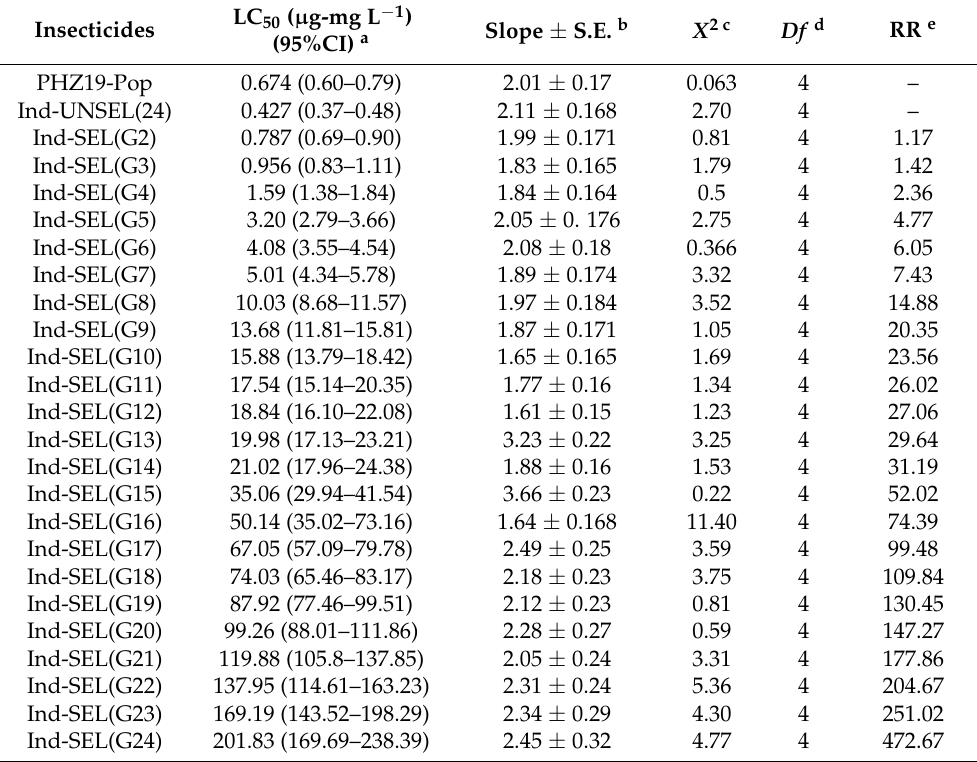
Table 1. LC 50 values with a resistance ratio of laboratory selection of S. frugiperda with indoxacarb in field-collected strains after selection in various generations